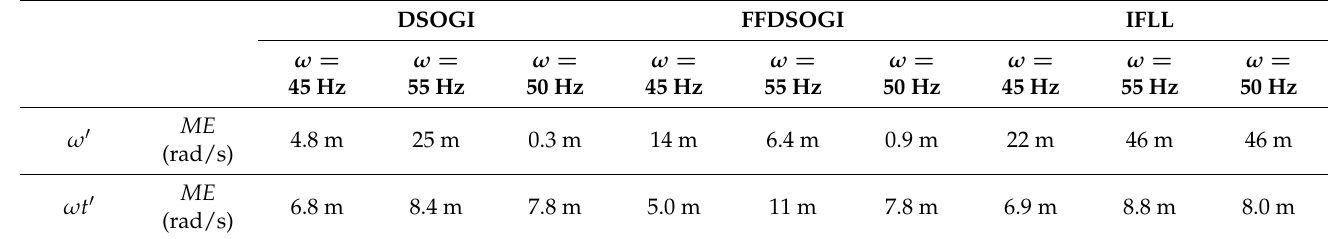
Table 9. Results summary obtained for test #2—steady state